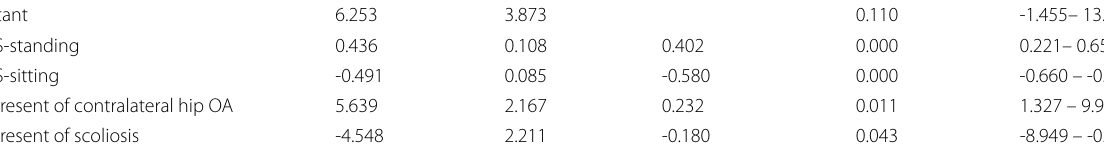
SS sacral slope, OA osteoarthritis